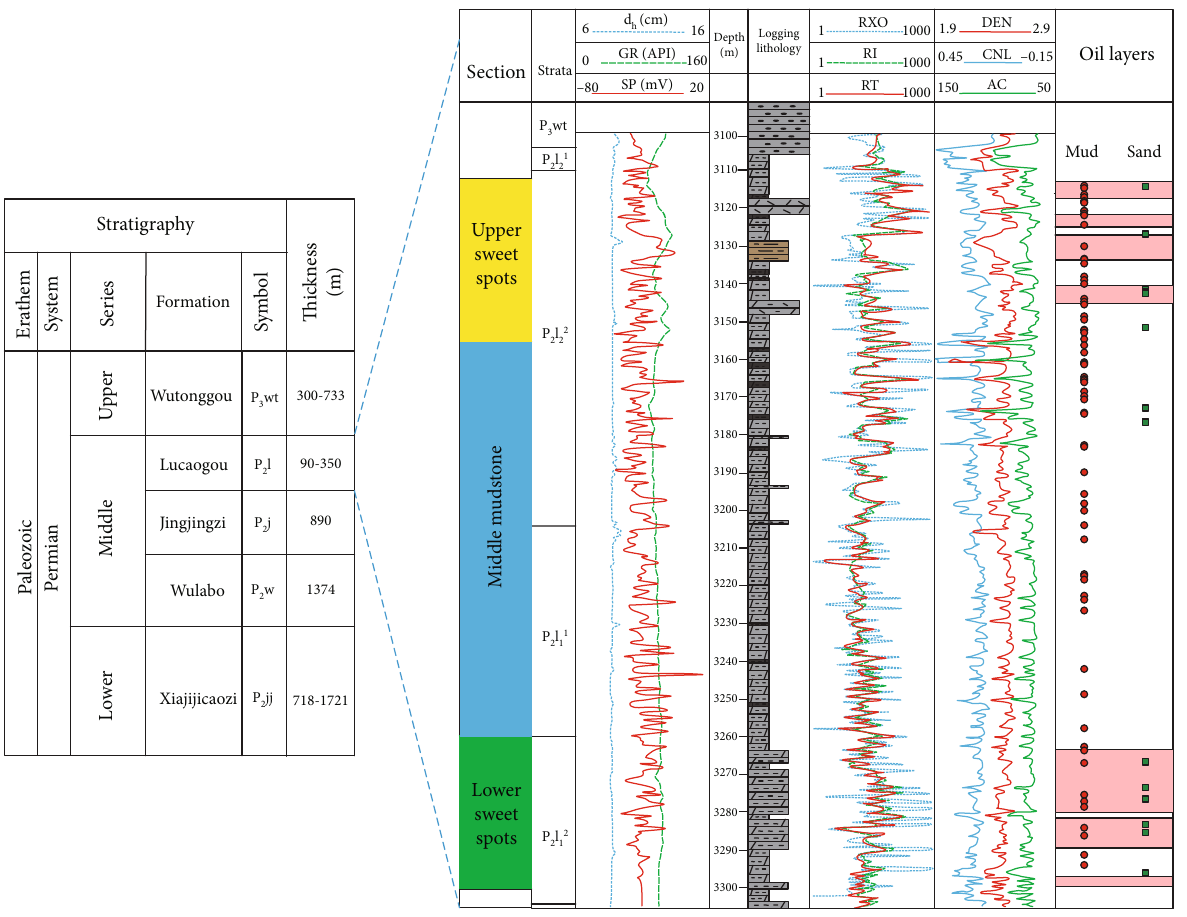
l 12 : lower part of the lower Lucaogou 2 l 22 : lower part of the upper Lucaogou Formation; P l 21 : upper part of 2 2